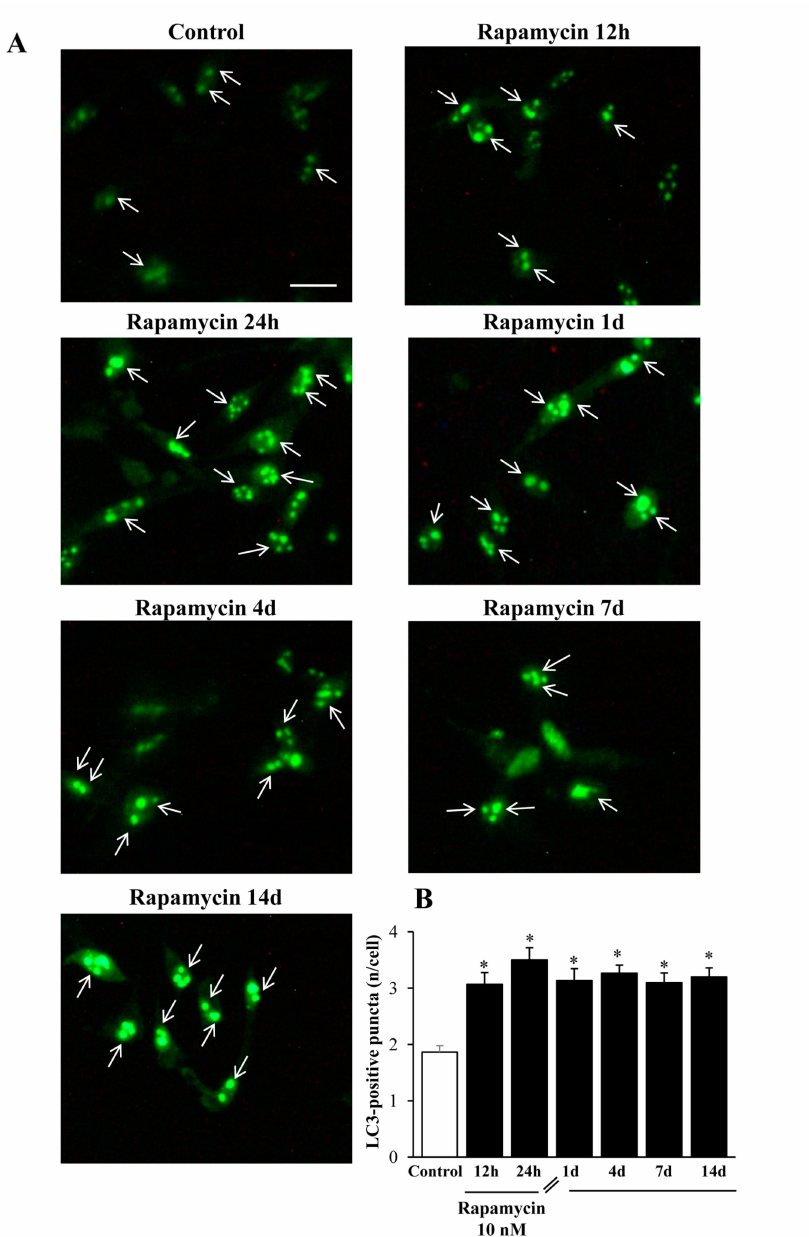
Figure14. RapamycinincreasestheimmunofluorescenceofLC3withinU87MGcells. ( A )Representative immunofluorescence from U87MG cells. White arrows point to LC3 puncta (green). ( B ) Graph reports the number of LC3 puncta per cell. Values were obtained from 100 cells per group. * p ≤ 0.05 vs. Control. Scale bar: 20 µ